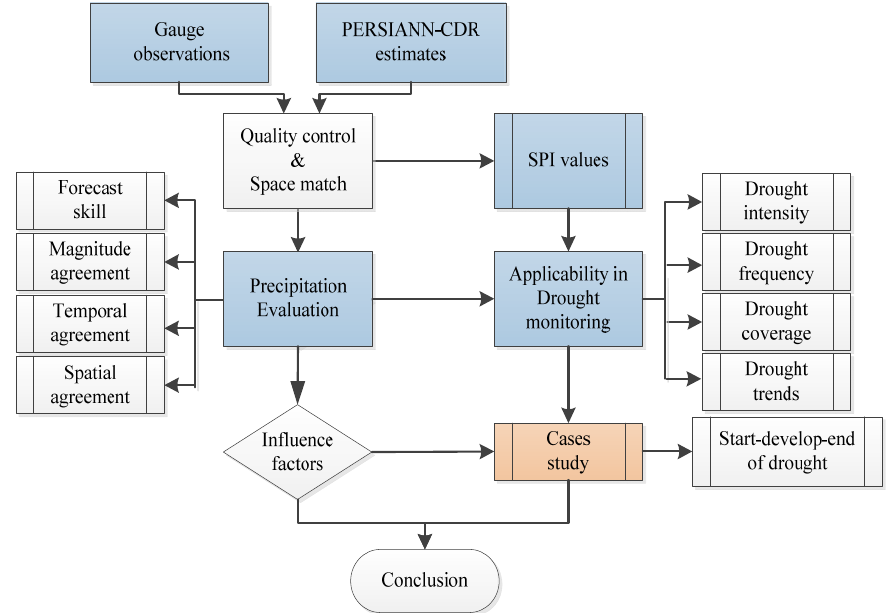
Figure 1. A diagram of the methodological